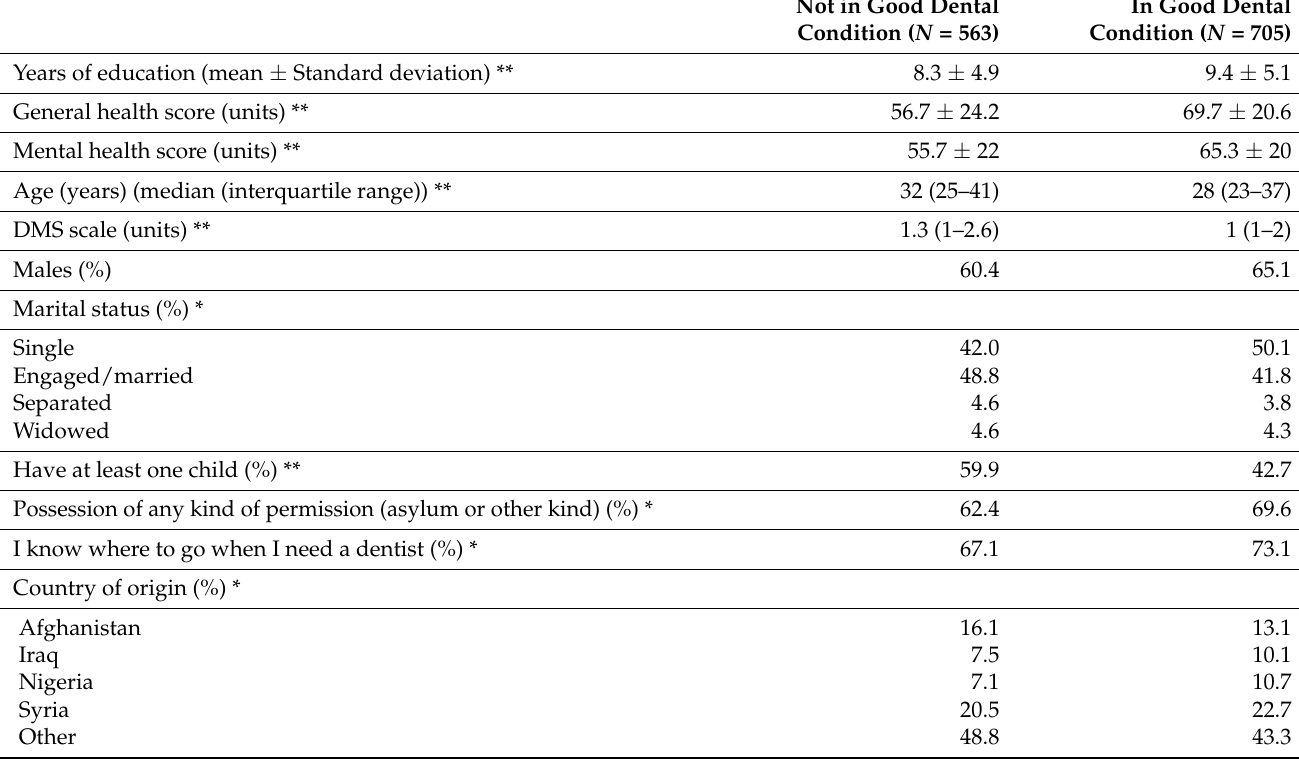
Table 3. Descriptive characteristics and other variables by dental/teeth condition.